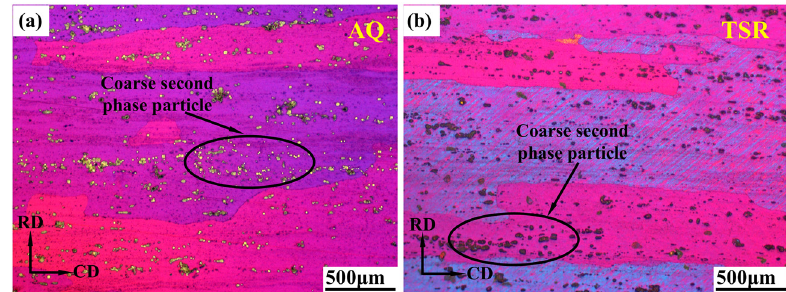
Figure 9: OM images of grain structures and coarse second - phase particles: ( a ) AQ piece and ( b ) TSR piece.